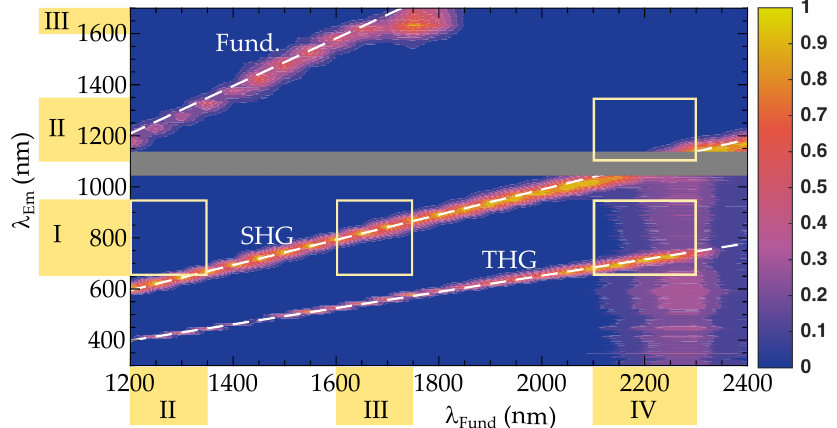
Figure 2. Normalized intensity (logarithmic scale) of harmonic emission in false colors in the wavelength range from 266–1720 nm as a function of the pump wavelength in the range from 1200–2400 nm. All data were obtained by means of nonlinear diffuse fs-pulse reflectometry with LN:Mg nanoparticle powder pellets, as described in the text. Color coding according to the legend on the right. The greyish area marks the spectrometers dead zone, i.e., the transition regime between the VIS and NIR spectrometer. The dashed white lines shows the result of the fitting procedure. The yellow boxes represent the principle regimes for NIR-to-NIR pairing of the biological optical windows NIR-II/NIR-I, NIR-III/NIR-I, NIR-IV/NIR-I, and